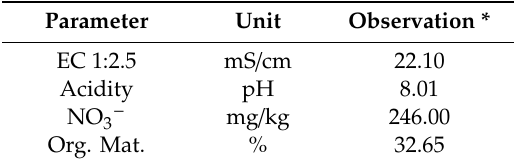
Table 1. Organic matter, nitrogen content, acidity and electrical conductivity (EC) in stabilized organic amendment (SOA)